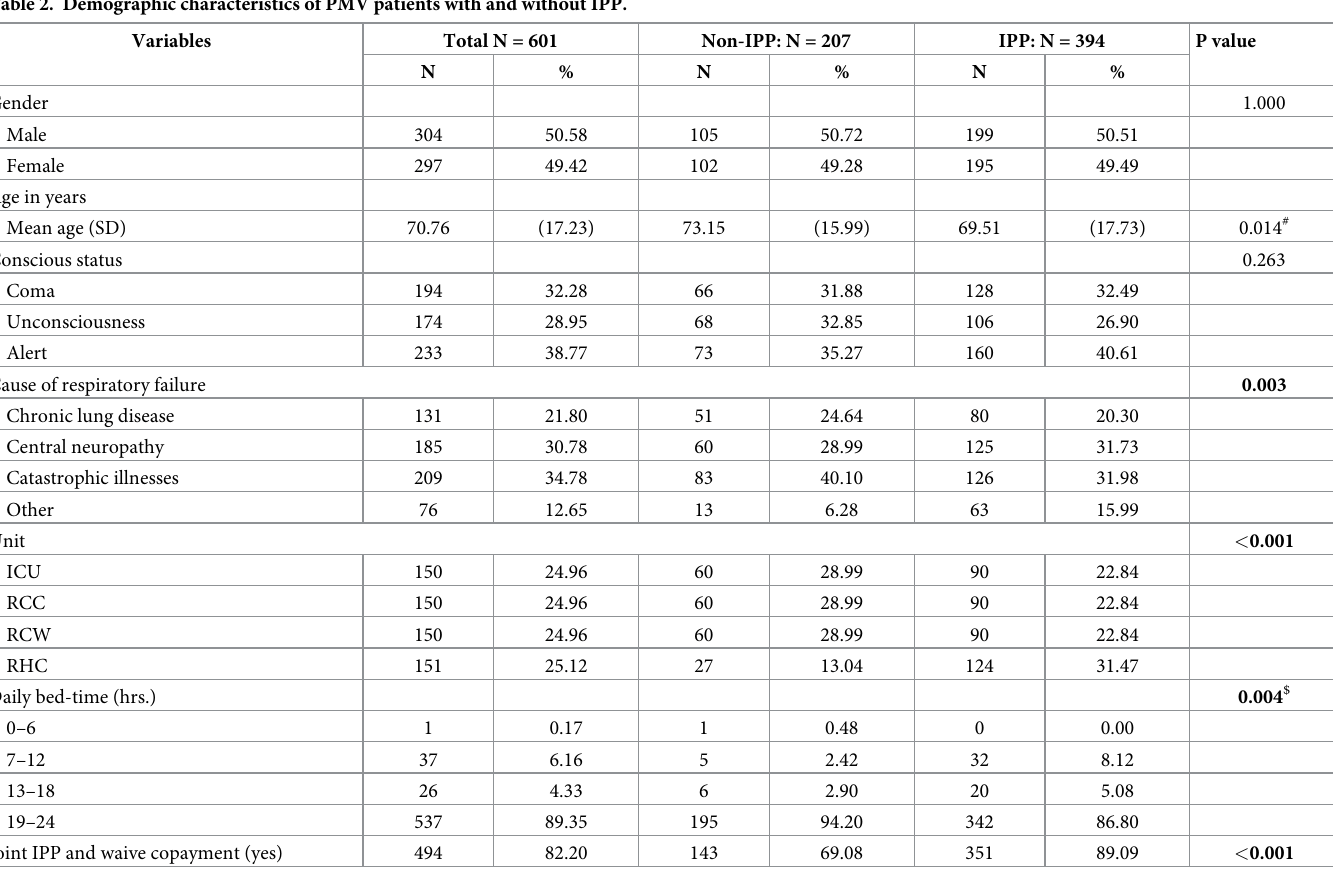
Table 2. Demographic characteristics of PMV patients with and without